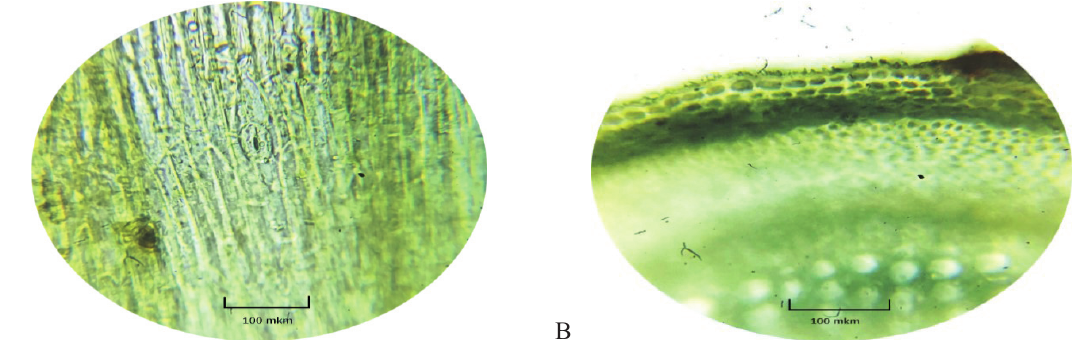
Figure 5. A . T. pratense stem epidermis; B . Trifolium pratense stem lamellar collenchyma